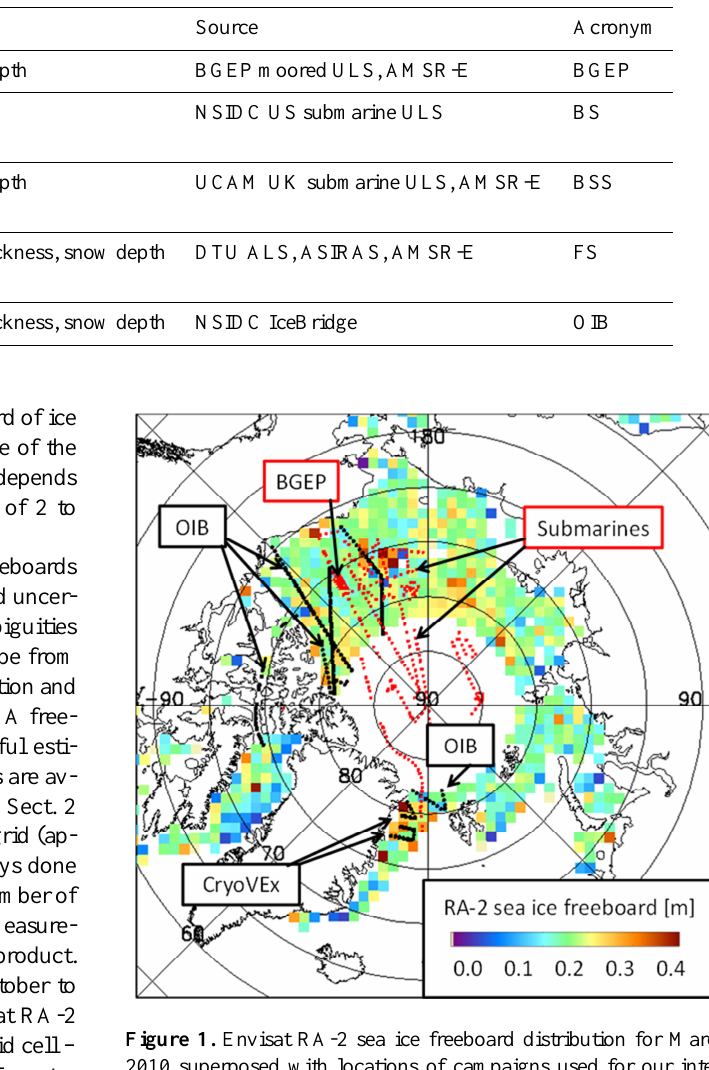
Table 1. Validation data used in the RRDP for sea ice thickness.